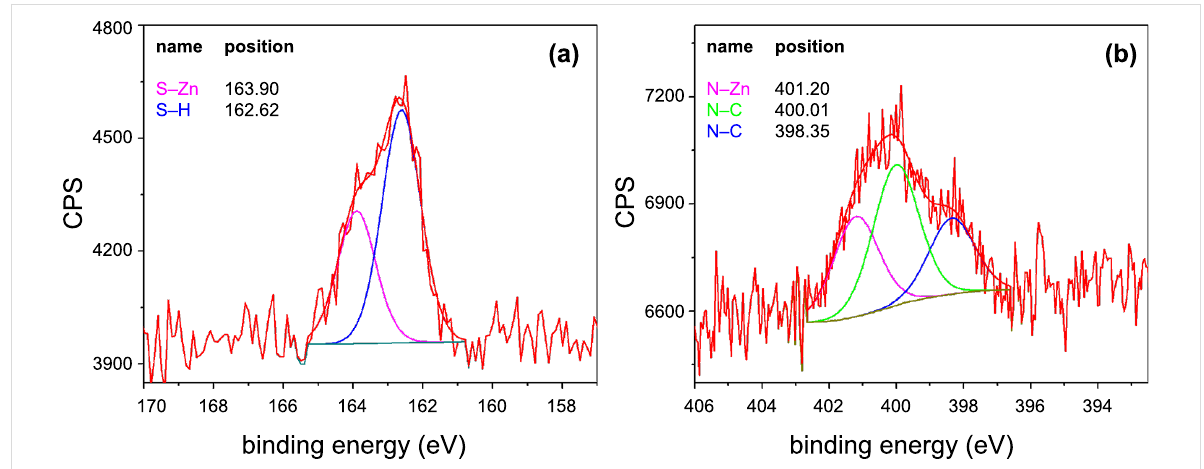
Figure 4: XPS spectra of (a) the sulfur peak of DT-functionalised ZnO NW sensor surface and (b) the amide peak of THMA-functionalised ZnO NW sensor surface.